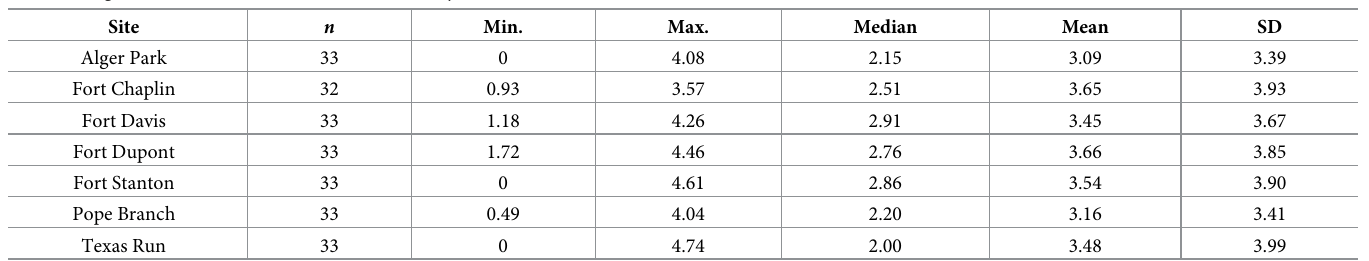
Table 2. Log 10 E . coli (MPN/100 ml) measurements by site. Site n Min.